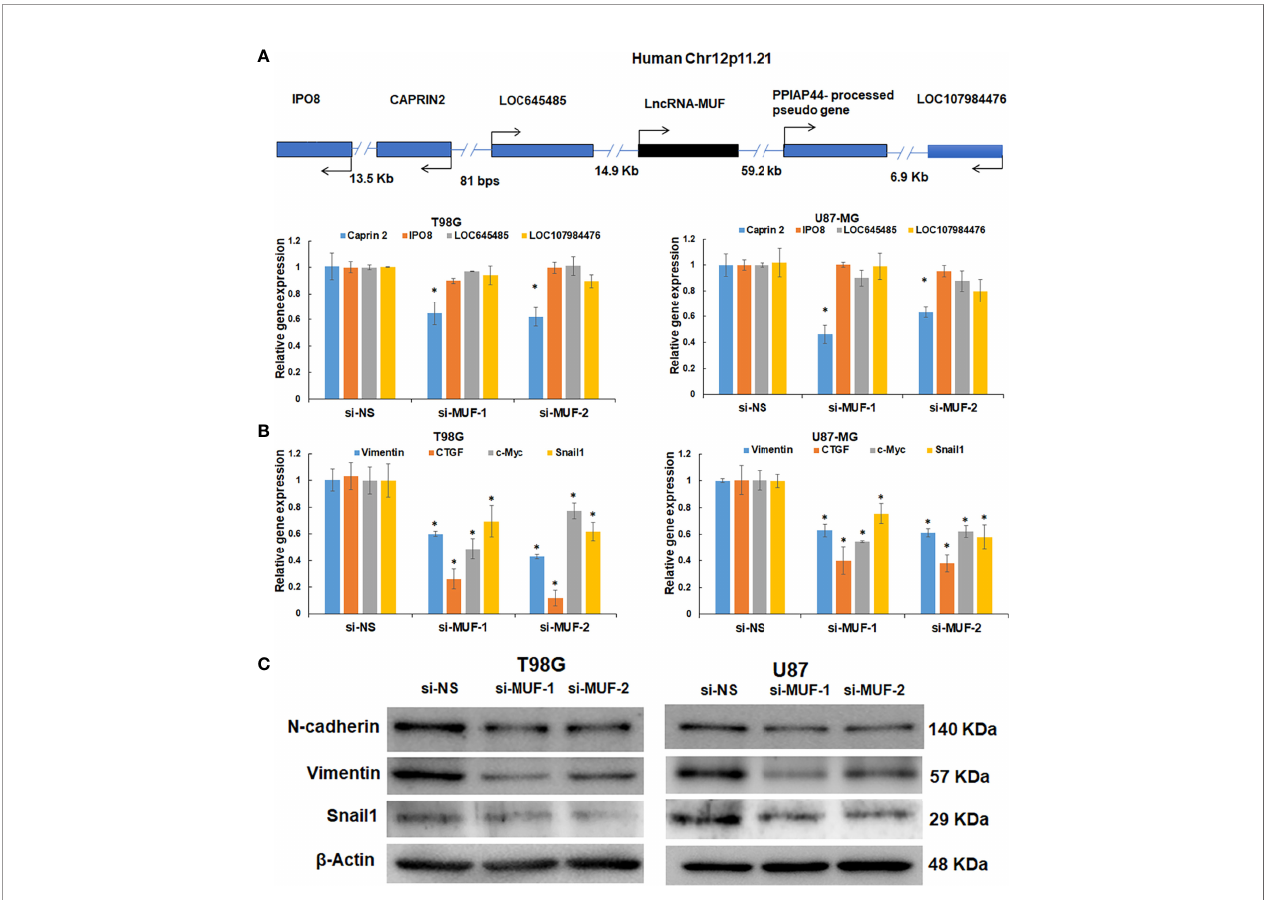
FIGURE 4 | LncRNA-MUF modulates gene expression in cis and trans and promotes EMT in glioma. (A) Validation of cis gene expression of lncRNA-MUF with lncRNA knockdown. LncRNA knockdown represses cis gene expression (Caprin2). (B) LncRNA-MUF modulates TGF- b target gene expression in trans in GBM. T98G and U87- MG glioma cells transfected with si-NS, si-MUF-1, or si-MUF-2 (25 nM), and transcript levels of indicated genes were measured 48 h post-transfection. RNA samples were analyzed by quantitative RT-PCR, and error bars represent the mean ± SEM from three independent experiments. (C) LncRNA-MUF promotes GBM EMT. Western blot analysis of EMT markers Vimentin, N-cadherin, and Snail1 followed by lncRNA-MUF knockdown in T98G and U87-MG cells. *Signi fi cant change compared to cells transfected with si-NS (p < 0.05). Values represent mean ± SD from three independent